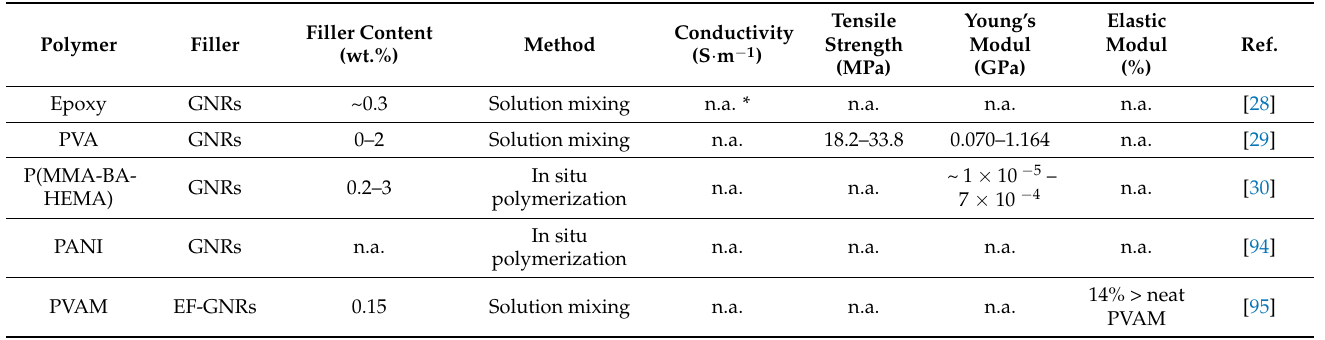
Table 3. Electrical conductivity and mechanical properties of GNRs/polymer nanocomposites. Filler Content Polymer Filler